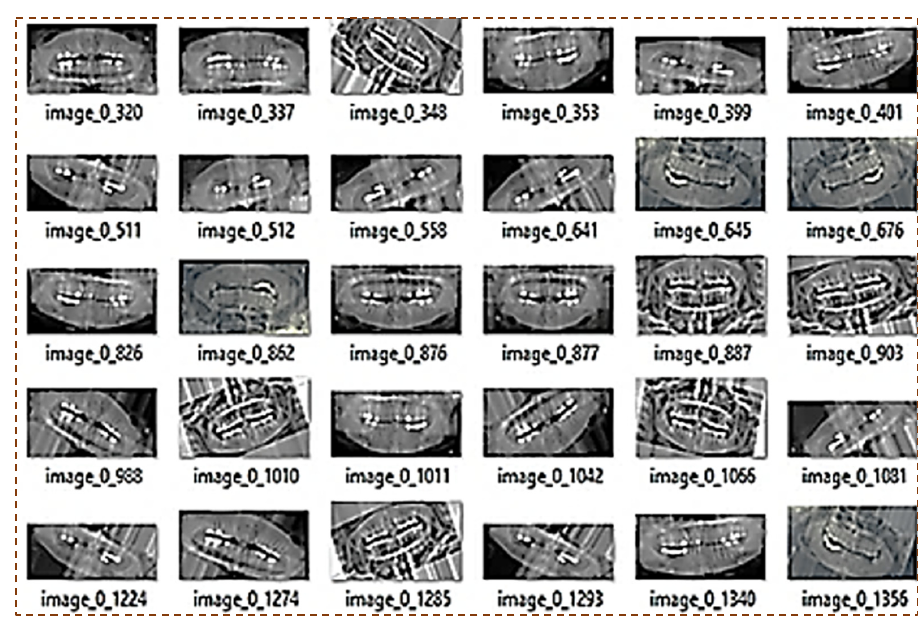
Figure 3. Custom dataset after augmentation.